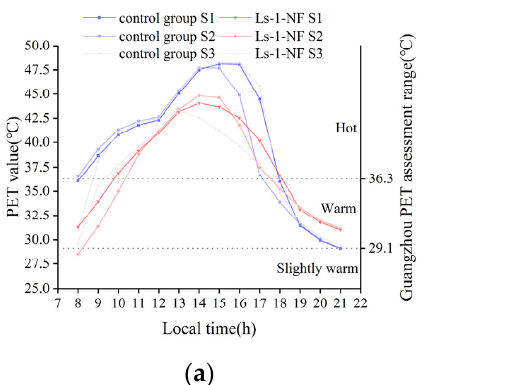
Figure 17. Effects of planting arbors on wind speed in different walking spaces in summer ( a ) and winter ( b ) .